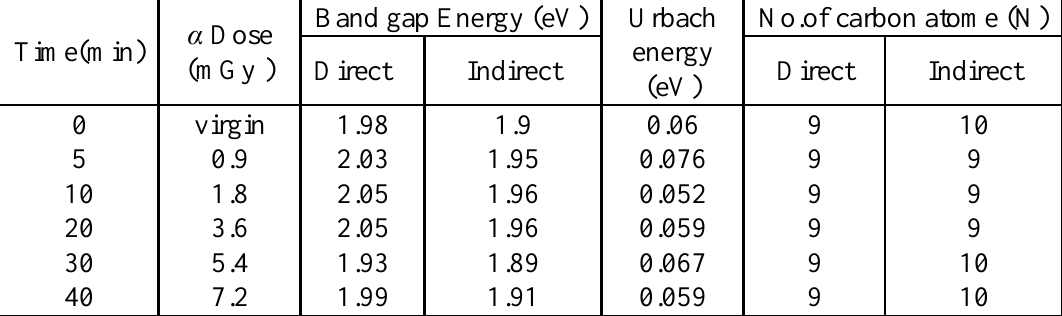
Table 1: Variation of band gap energy and Urbach’s energy in the pristine and alpha irradiated LR- 115 with number of carbon atoms (N) per conjugated